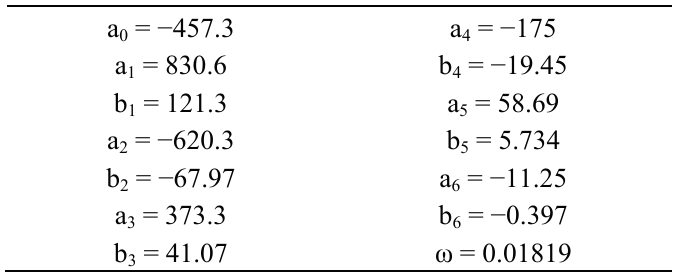
Table 1. The parameters of Equation (3).